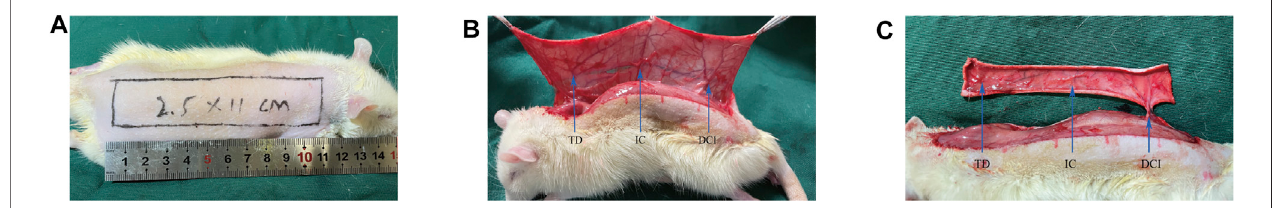
FIGURE1| Multiterritoryperforatorskin fl ap model. (A) Scopeof fl ap establishment. (B) The three mainarteriesaredeep circum fl ex(DCI),thoracodorsal(TD), and posterior intercostal (IC). (C) IC and TD were disconnected, and DCI was